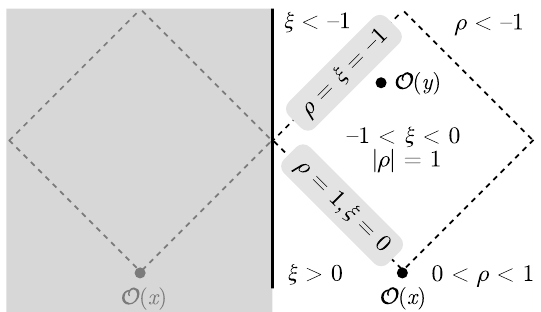
Figure 5. We depict various regions of the Lorentzian interval for a BCFT in terms of various cross-ratios. Importantly we note that the causal diamond bounded by the lightcone of the operator O ( x ) and its reflection off the boundary is described by the radial cross-ratio ρ living on the unit circle. It interpolates between the initial lightcone at ρ = e i 0 and the reflected ligthcone at ρ = e iπ